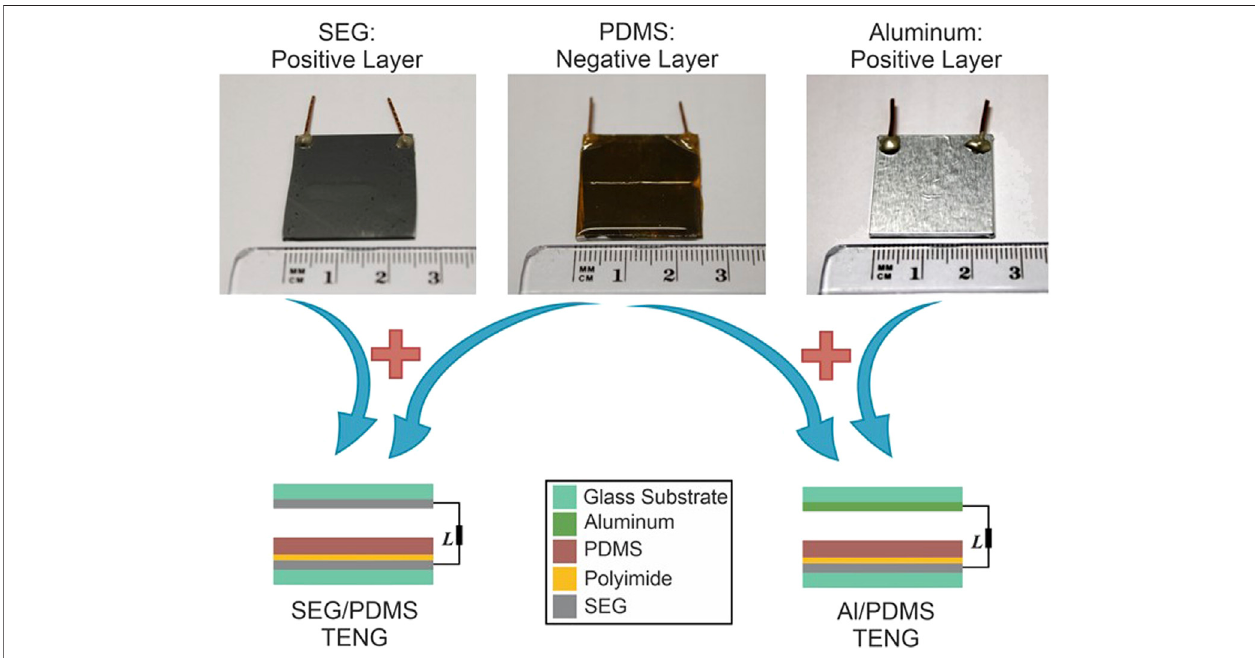
FIGURE1| SchematicforaSEG/PDMSTENG(bottomleft)andforanAl/PDMSTENG(bottomright)withpicturesofcorrespondingcomposingtriboelectricparts.